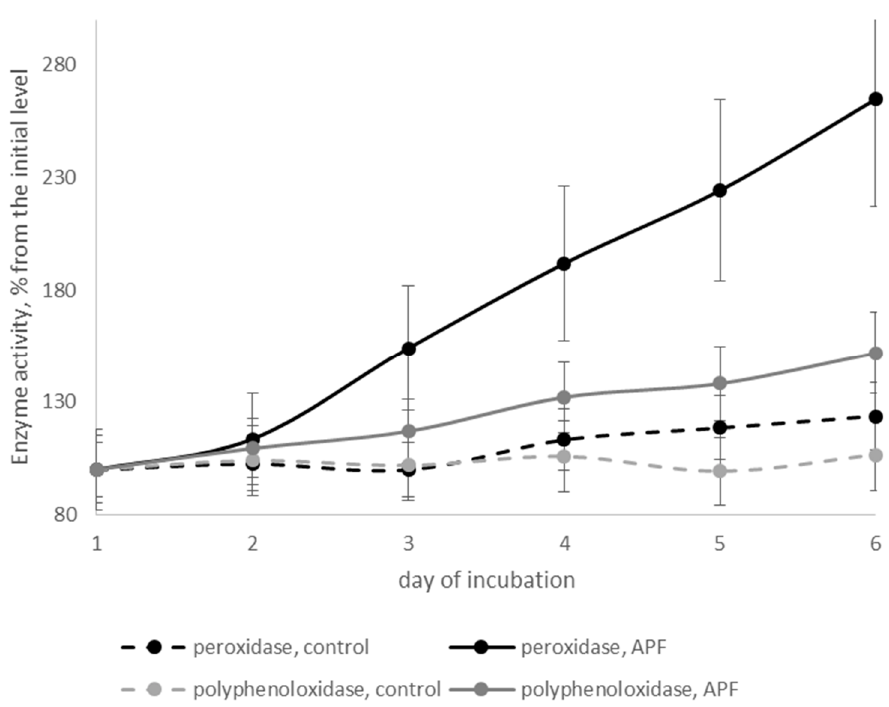
Figure 6. Peroxidase and polyphenoloxidase activity in the tissue of cherry tomatoes infected with F. oxysporum and treated with APF of B. mojavensis P1709.